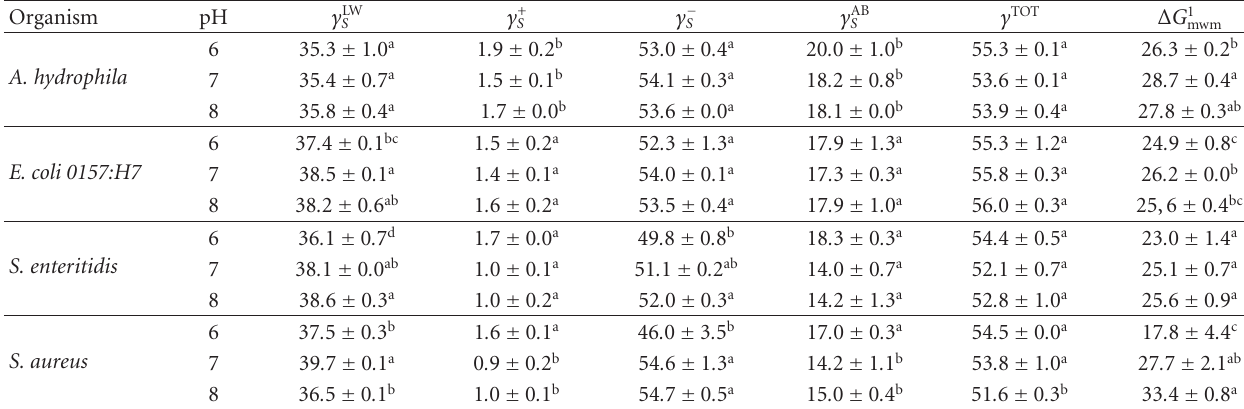
Table 4: Surface tension and hydrophobicity (mJ · m − 2 ) of the four pathogens determined from contact angle measurement.